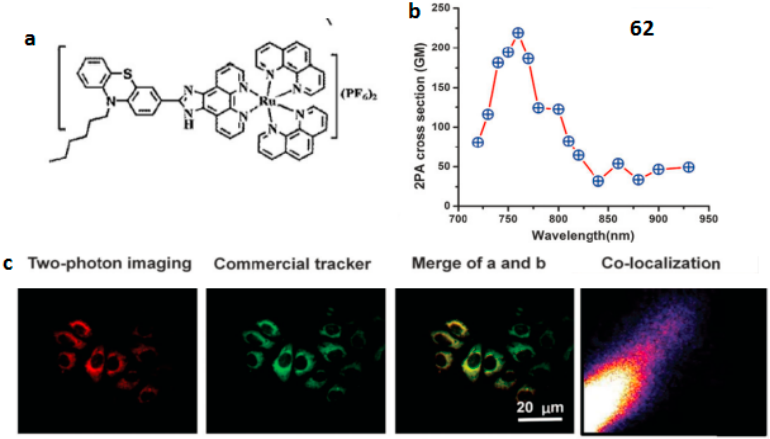
Figure 15. ( a ) Molecular structures of 62 ; ( b ) 2PA cross-sections of 62 in DMSO (dimethylsulphoxide) solution ( c = 1 × 10 − 3 mol·L − 1 ); ( c ) 2PFM of HepG2 cells co-labeled with 52 and Mitotracker.